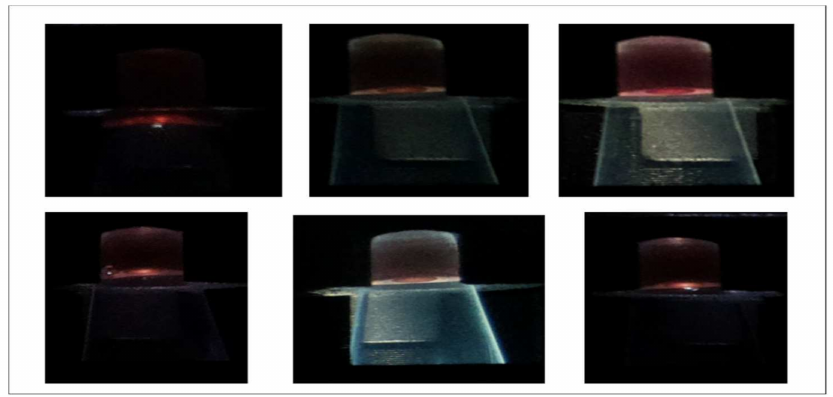
Figure 5. Different types of noise present in the data